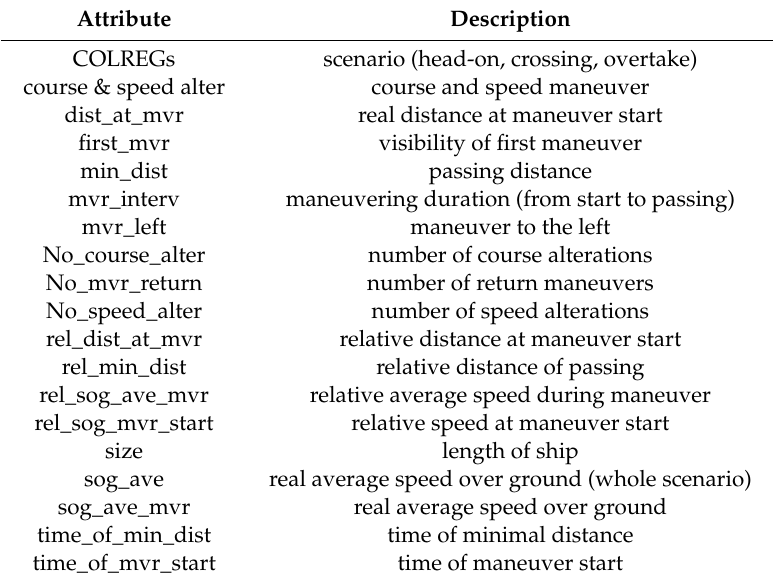
Table 2. Descriptions of input attributes.